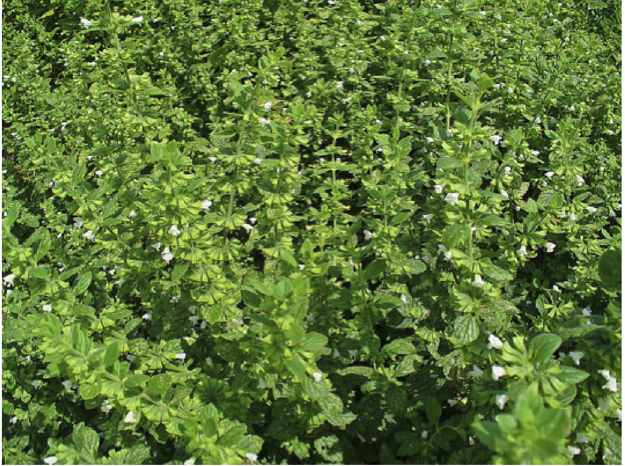
Fig. 1: Melissa officinalis L.